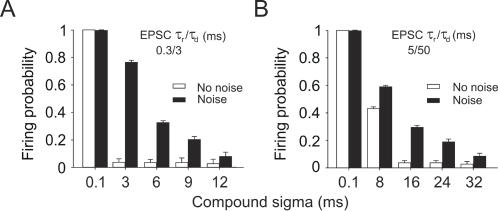
Reliability of spike responses to unsynchronized compounds is significantly increased by background synaptic noise. A Firing probability in response to a fast compound EPSC plotted versus different compound sigma values with and without background noise. B Firing probability in response to a slow compound EPSC plotted versus different compound sigma values with and without background noise. For both EPSCs tested, the addition of background noise resulted in a significant increase in firing probability for each compound sigma and - particularly for the fast compound EPSC - in a more gradual decline of firing probability with increasing compound sigma. Data shown are averaged across three cells.